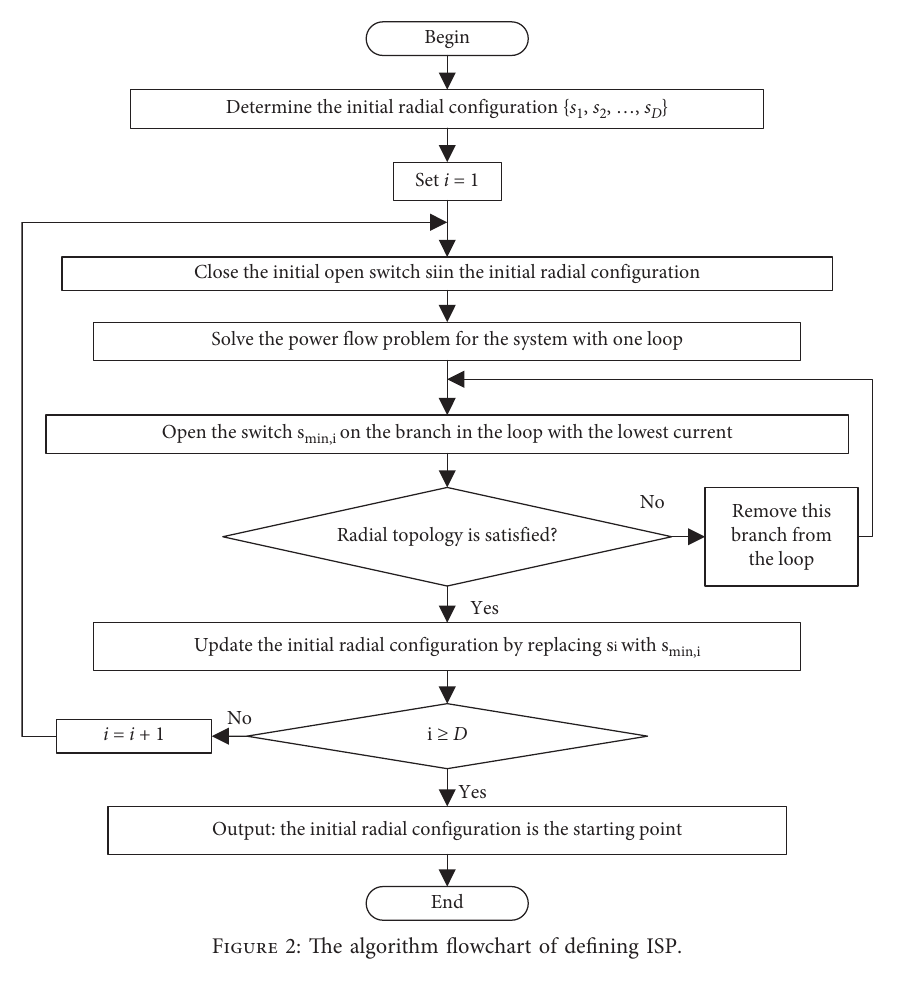
Figure 2: The algorithm flowchart of defining ISP.